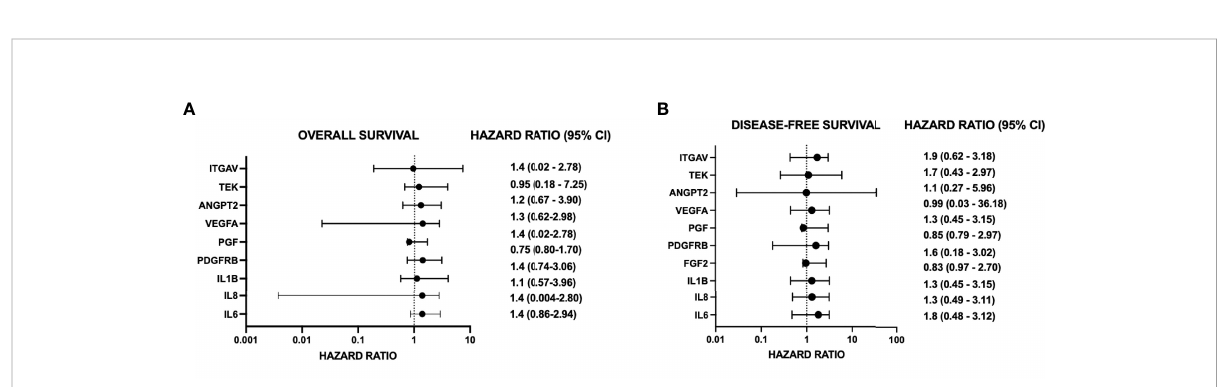
FIGURE 6 Forest plots demonstrate hazard ratios and 95% con fi dence intervals (CI) for angiogenic genes signi fi cantly changed by targeting TRAF3IP2. Data are from The Cancer Genome Atlas (TCGA), accessed through GEPIA (http://gepia.cancer-pku.cn). Group cutoff for high expression vs. low expression of the gene of interest is the median. Hazard ratio (HR) is calculated based on the COX proportional hazard model. Hazard ratios are for the “ high expression ” group for each gene and refer to overall survival (OS) Panel (A) or disease-free survival (DFS) Panel (B)